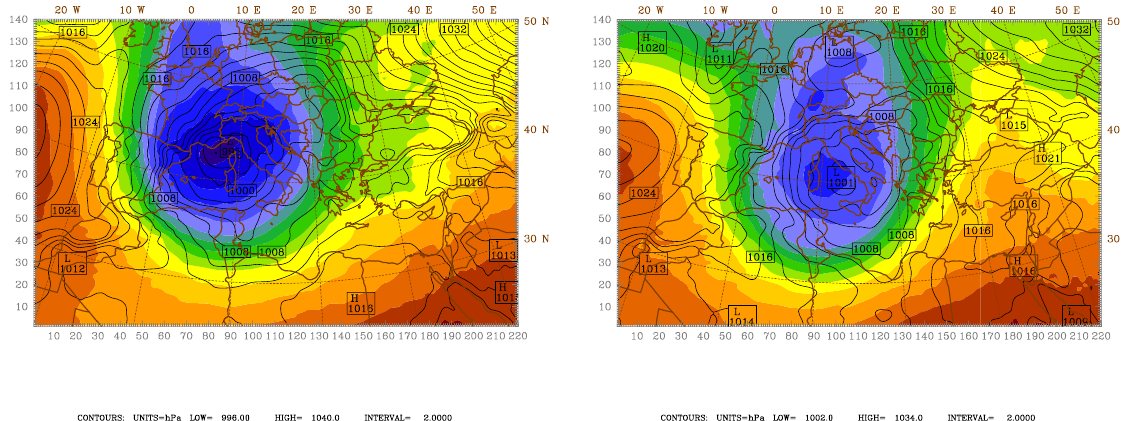
Fig. 4. Sea level pressure (hPa) and 500 hPa height (gpdm) for 00:00 and 24:00 UTC of 9 November 2009.